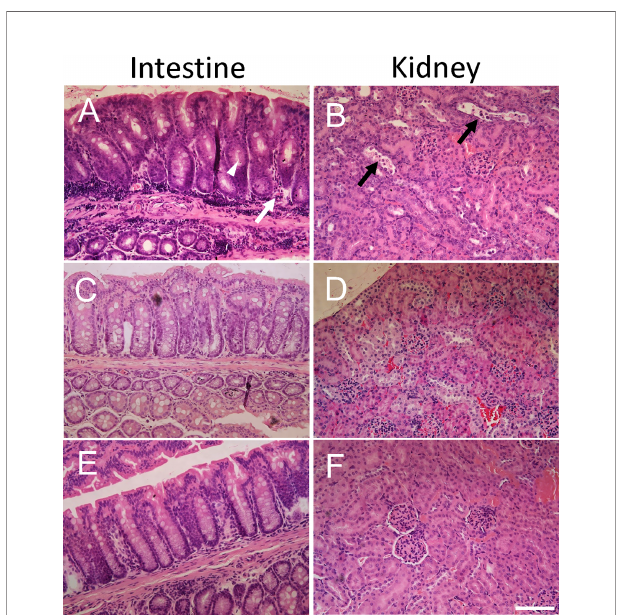
FIGURE 3 | Blood urea nitrogen levels in E. coli O157:H7-infected mice. Blood urea nitrogen measured in plasma from E. coli O157:H7 (EHEC) infected and uninfected mice. Two mice in the infected and IgG-treated day 3 and 6 group developed symptoms and these are the two in this group with high BUN values. Data presented as median and individual values representing individual mice. *P < 0.05.